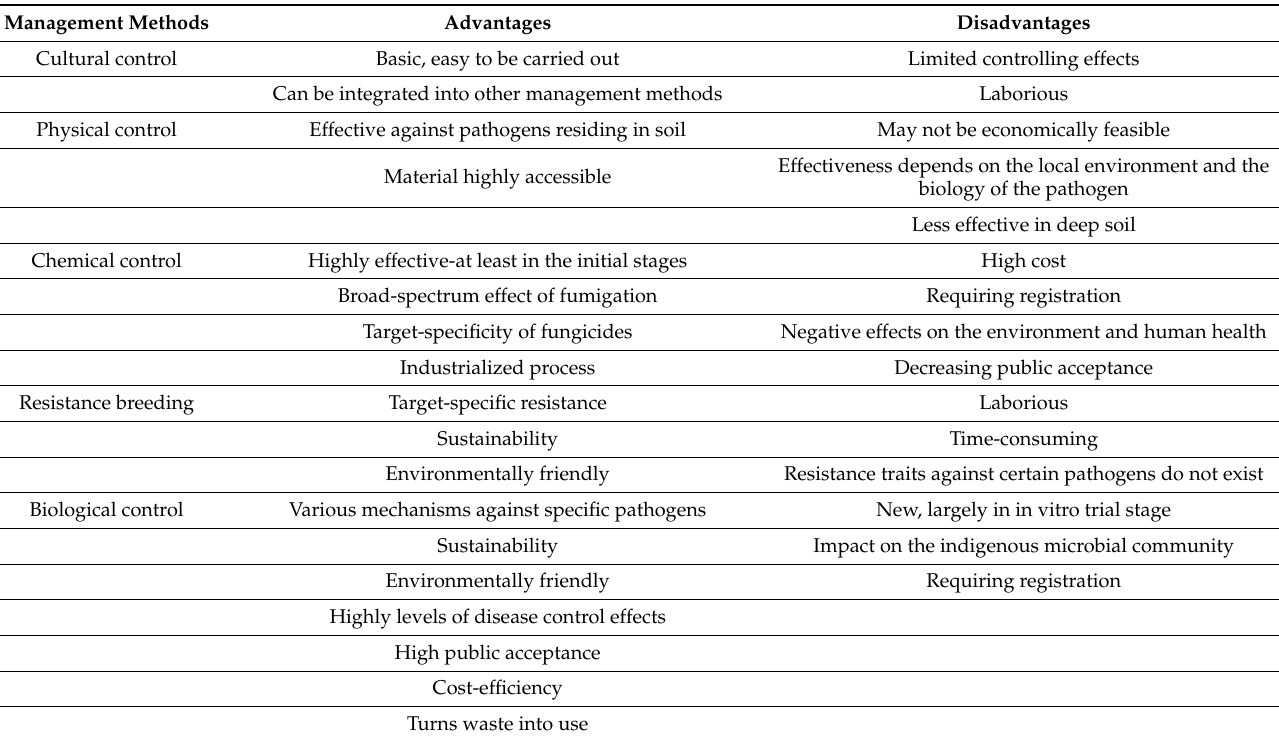
Table 2. Advantages and disadvantages of the management methods concluded from this